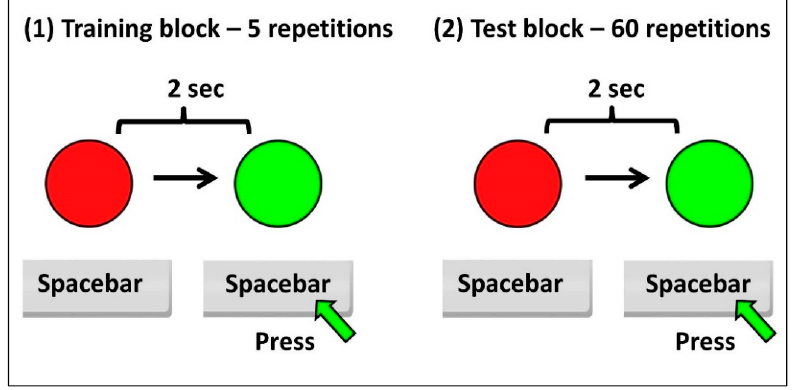
Figure 1. Schematic of the RT experiment. (1) Training block- 5 repetitions; (2) Test block-60 repeti-